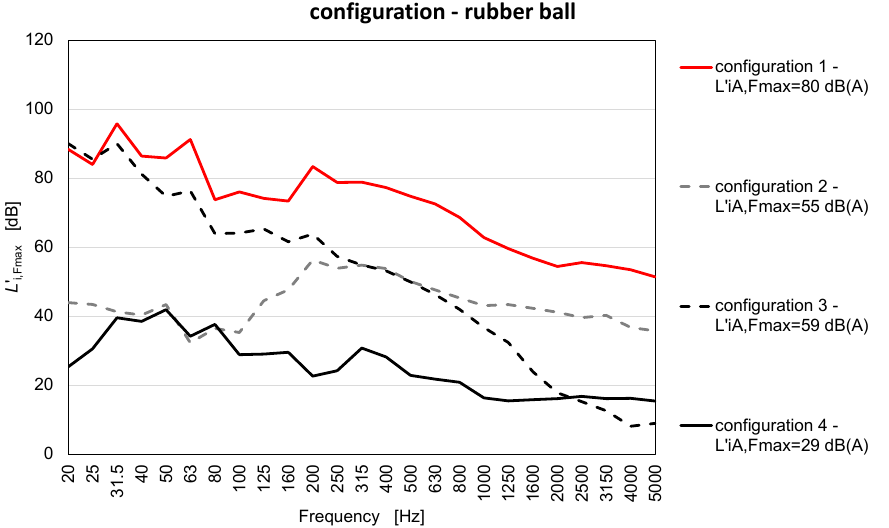
Figure 13. Impact sound pressure level for CLT floors (configurations 1, 2, 3, and 4). Source: rubber ball.